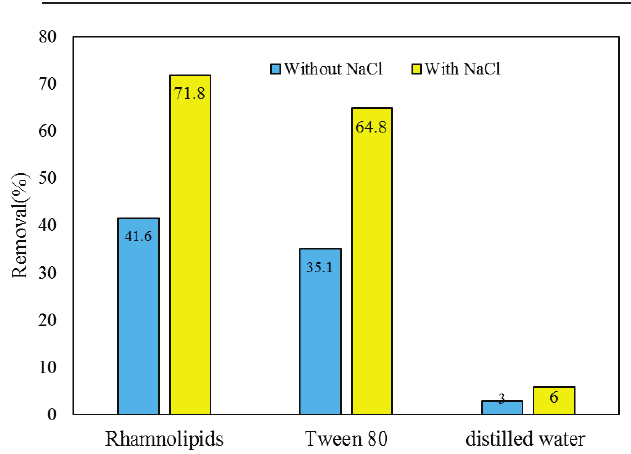
Fig. 8 – Soil washing efficiency using rhamnolipid­based biosurfactant solution, Tween 80 solution and distilled water under selected conditions (pH = 7, concentration = 7 CMC, contact time = 72 h, and NaCl = 4